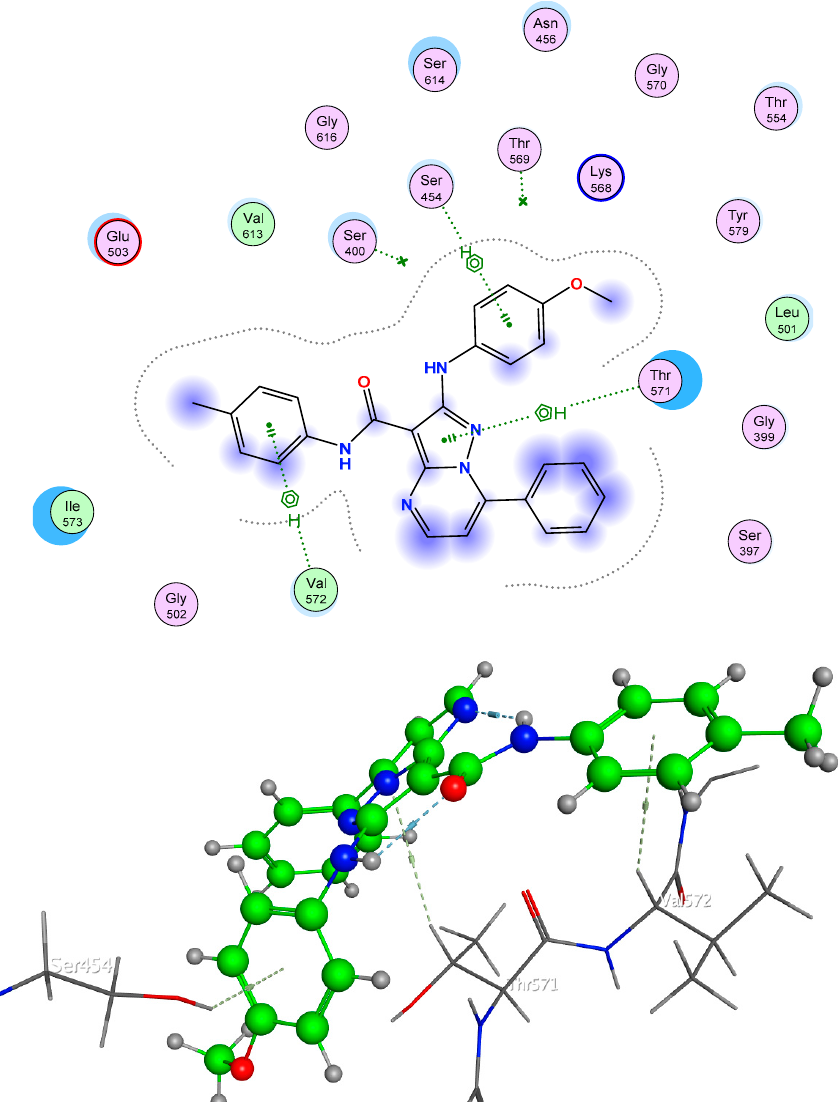
Figure 4. 2D and 3D interaction diagrams of compound 13d with transpeptidase.